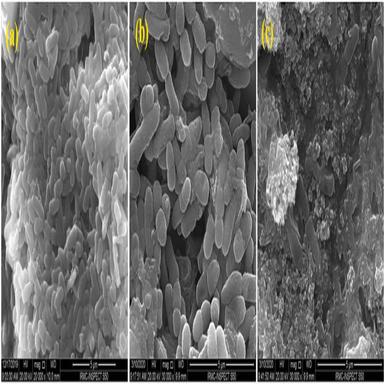
SEM images of untreated MDR-PA strains (a), pure g-C3N4 treated MDR-PA strains (b), and 10%-3C–SiC@g-C3N4 treated MDR-PA strains (c).